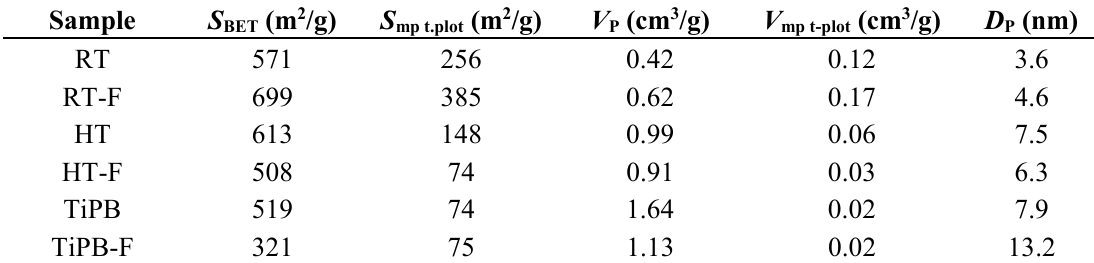
Figure 2. Nitrogen adsorption/desorption isotherms at − 196 °C of pure silicas: ( A ) without fluoride ( B ) with fluoride. Table 2. Textural properties of pure